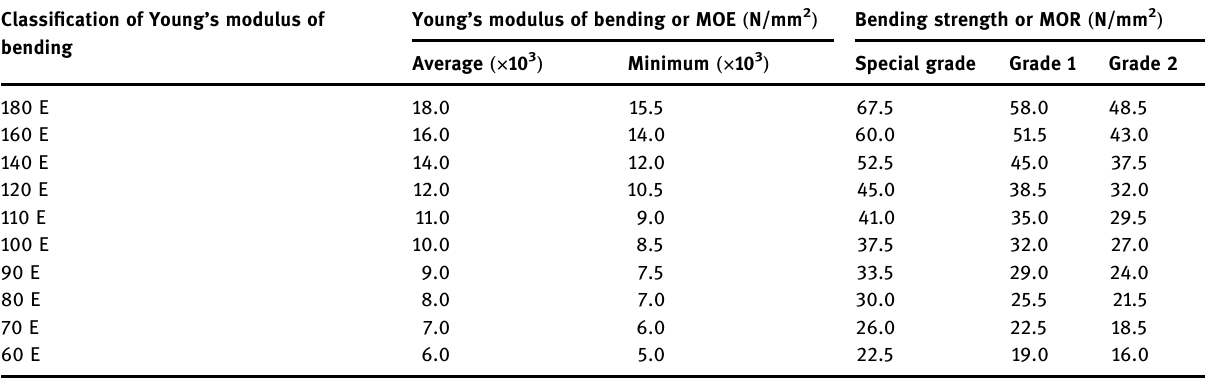
Young ’ s modulus of bending or MOE ( N/mm 2 )